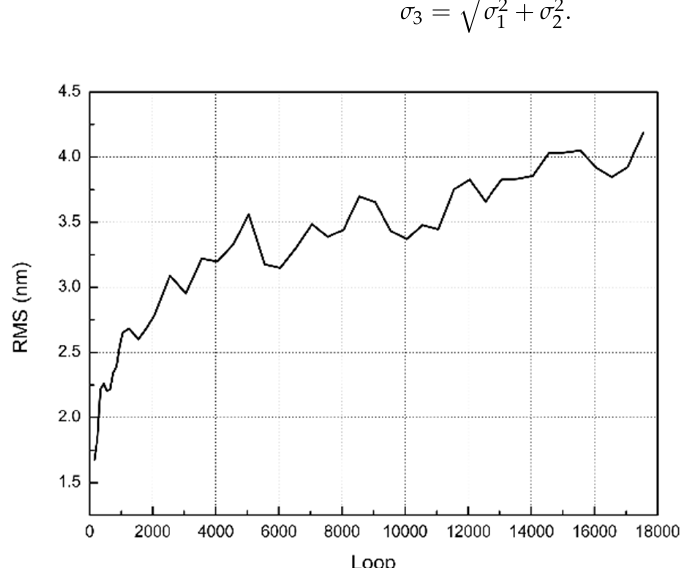
Figure 8. RMS roughness evolution for 17,550 loops with Gaussian blur over the entire surface. The curve is nonconvergent for one abrasive per loop with quasilinear growth after 4000 loops.